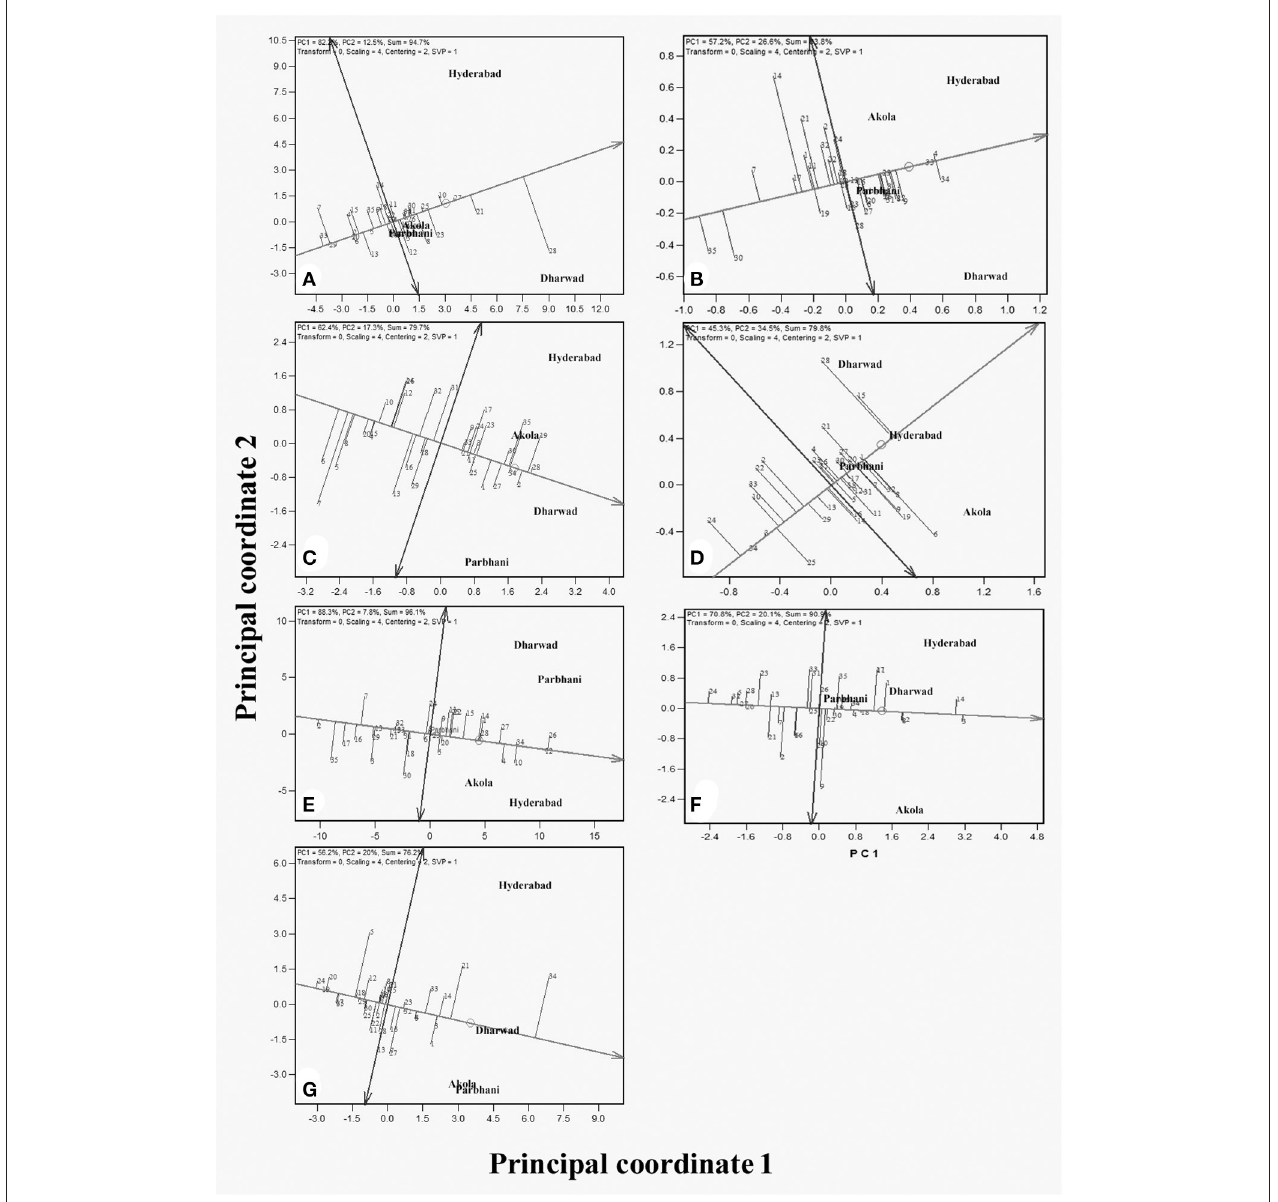
FIGURE 2 | GGE biplots from the combined analysis of data from 35 genotypes (1–35) evaluated across four locations for the traits: (A) grain yield (GY), (B) grain mold score, (C) flowering time, (D) 100-grain weight (HGW), (E) plant height (PH), (F) panicle length (PL), and (G) glume